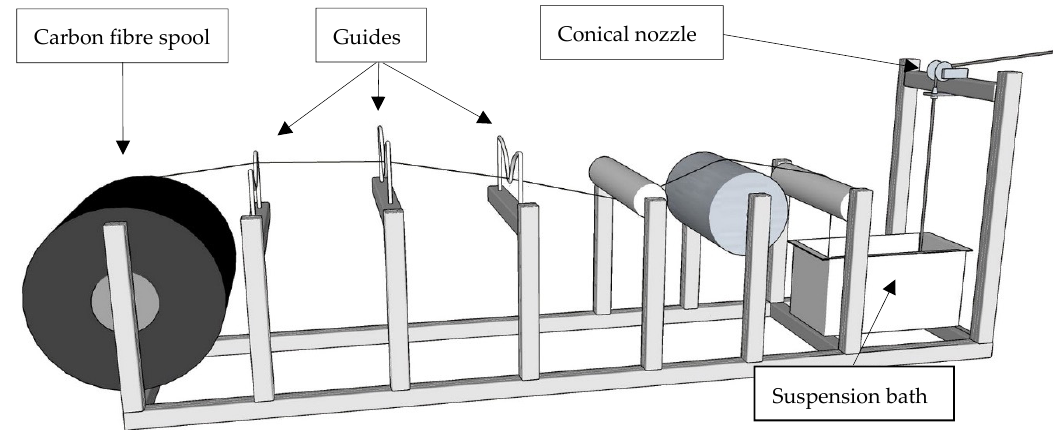
Figure 1. Stationary yarn impregnation